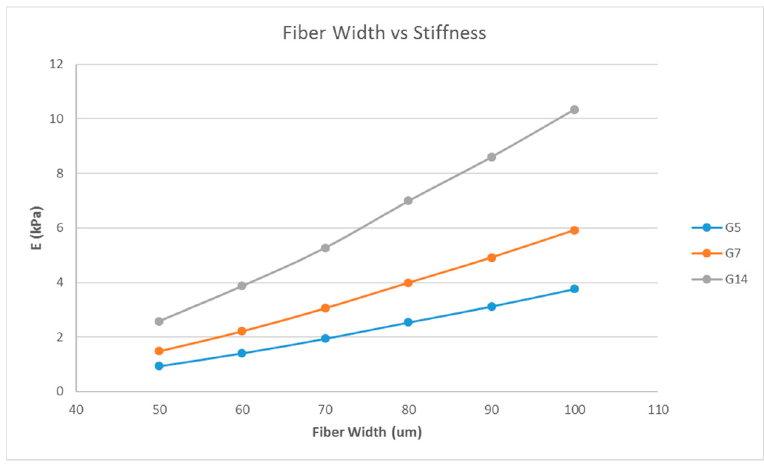
Figure 3. Effect of varying fiber widths on the stiffness of the structure consisting of a single layer with 16 unit cells with a fixed unit cell pore side length ( p = 200 µ m) for G5, G7, and G14.